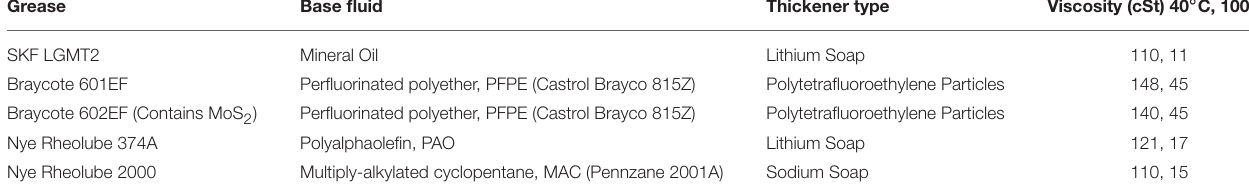
TABLE 1 | Summary of greases used in this study. Grease